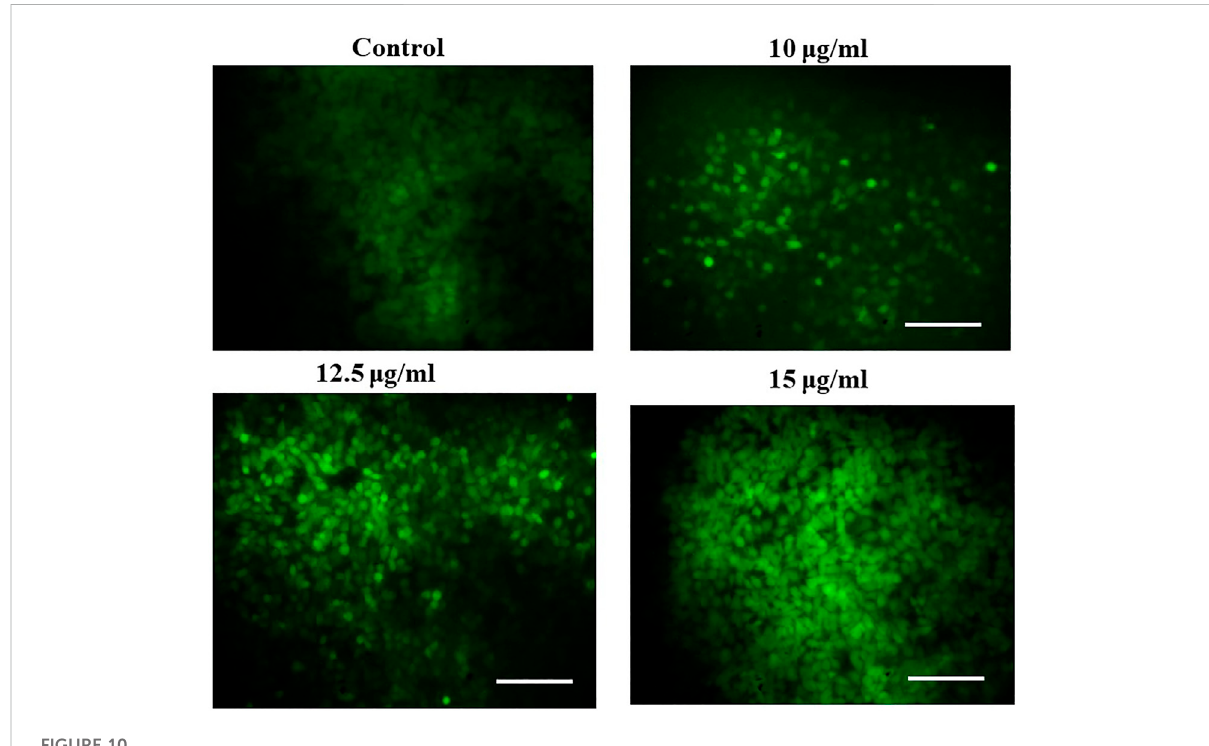
FIGURE 10 Effect of MgONPs on intracellular ROS generation in PA-1